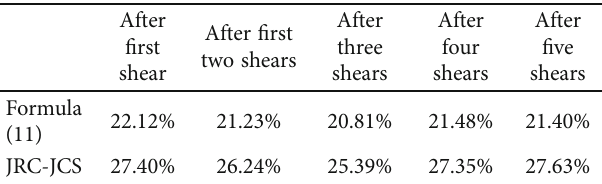
Table 4: Mean deviation between calculated value and test value of two